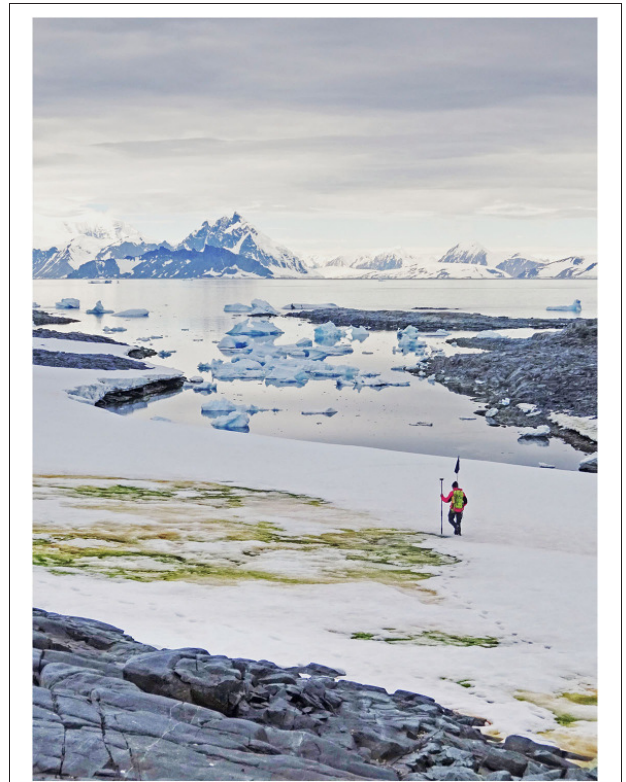
FIGURE 5 | Snow algae blooms on Anchorage Island. Photograph of Andrew Gray GPS tracing a green snow algal bloom on south-western tip of Anchorage Island, January 31, 2018 (Credit: M. Davey).